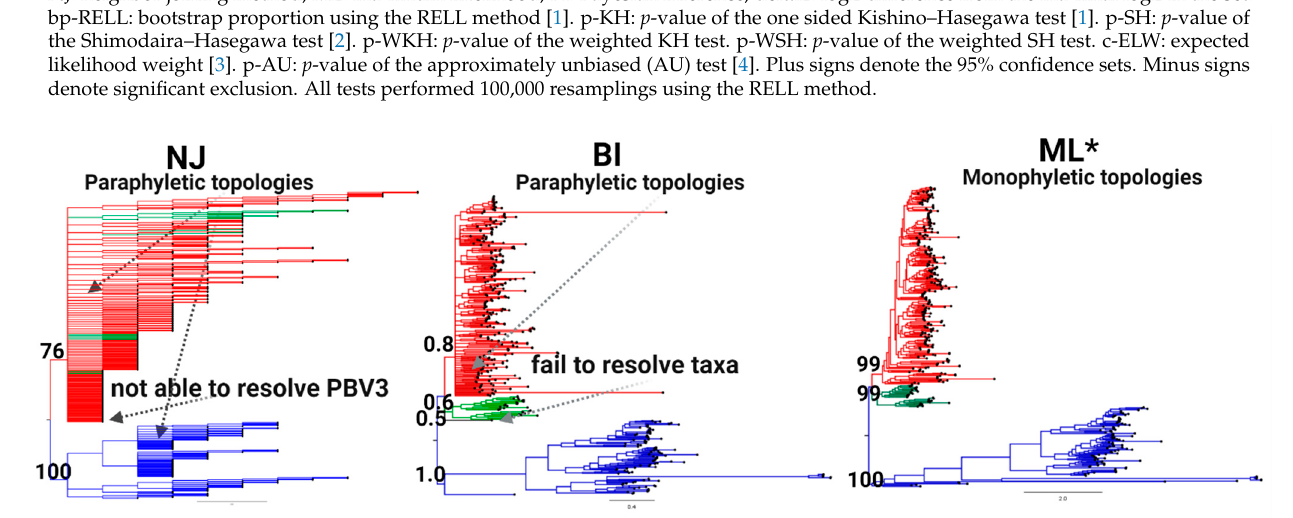
Figure 3. Phylogenetic tree topology comparison for classification of PBV. Tree topologies of the RdRp complete coding sequences obtained by neighbor joining (NJ; left), Bayesian inference (BI; middle), and maximum likelihood (ML; right) analyses are shown. Three main PBV lineages resolved are denoted by color (PBV1: red, PBV2: blue, and PBV3: green) with support for external nodes indicated by bootstrap/posterior probability values. Characteristics (monophyletic or paraphyletic) of each tree are indicated and the best topology supported by all statistical methods deployed (see the Materials and Methods) is denoted with an asterisk. Refer to Table 2 for the results of the